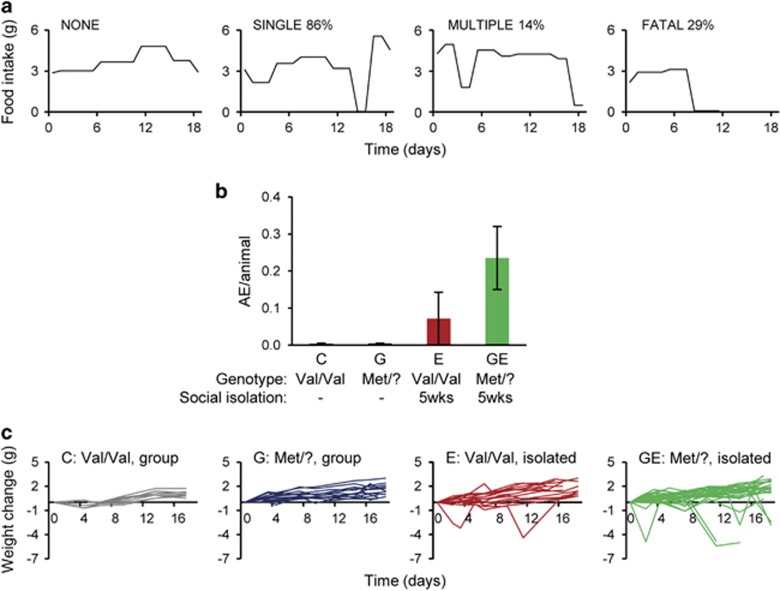
hBDNFMet/? genotype interacts with adolescent social stress to promote abnormal feeding behavior. (a) Different patterns of daily food intake in hBDNFMet/? females exposed to social isolation stress (GE). About 79.4% of animals maintained normal food intake throughout ‘NONE'. Of those that exhibited an AE, 85.7% exhibited only one aphagic episode (AE) ‘SINGLE', while 14.3% exhibited repeated AEs ‘MULTIPLE'. About 28.6% of the AEs resulted in death ‘FATAL'. Time 0 day starts at 7 weeks of age. (b) Number of aphagic episodes (AE) per animal per group from 7 to 9.5 weeks of age in group housed hBDNFVal/Val (C) and hBDNFMet/? (G) females; singly housed hBDNFVal/Val (E) and hBDNFMet/? (GE) females (C, 0 AE per animal, n=10, 2 cohorts; G, 0 AE per animal, n=13, 3 cohorts; E, 0.07±0.07 AE per animal, n=14, 3 cohorts; GE, 0.23±0.08 AE per animal n=34, 9 cohorts), ANOVA. (c) Body weight changes within respective groups, each line represents one animal. Time 0d starts at 7 weeks of age. (CTL, n=10; G, n=13; E, n=14; GE, n=34). Error bars denote s.e.m. ANOVA, analysis of variance; C, control; E, environmental stressor; G, genetic susceptibility; GE, genetic susceptibility and environmental stressor.